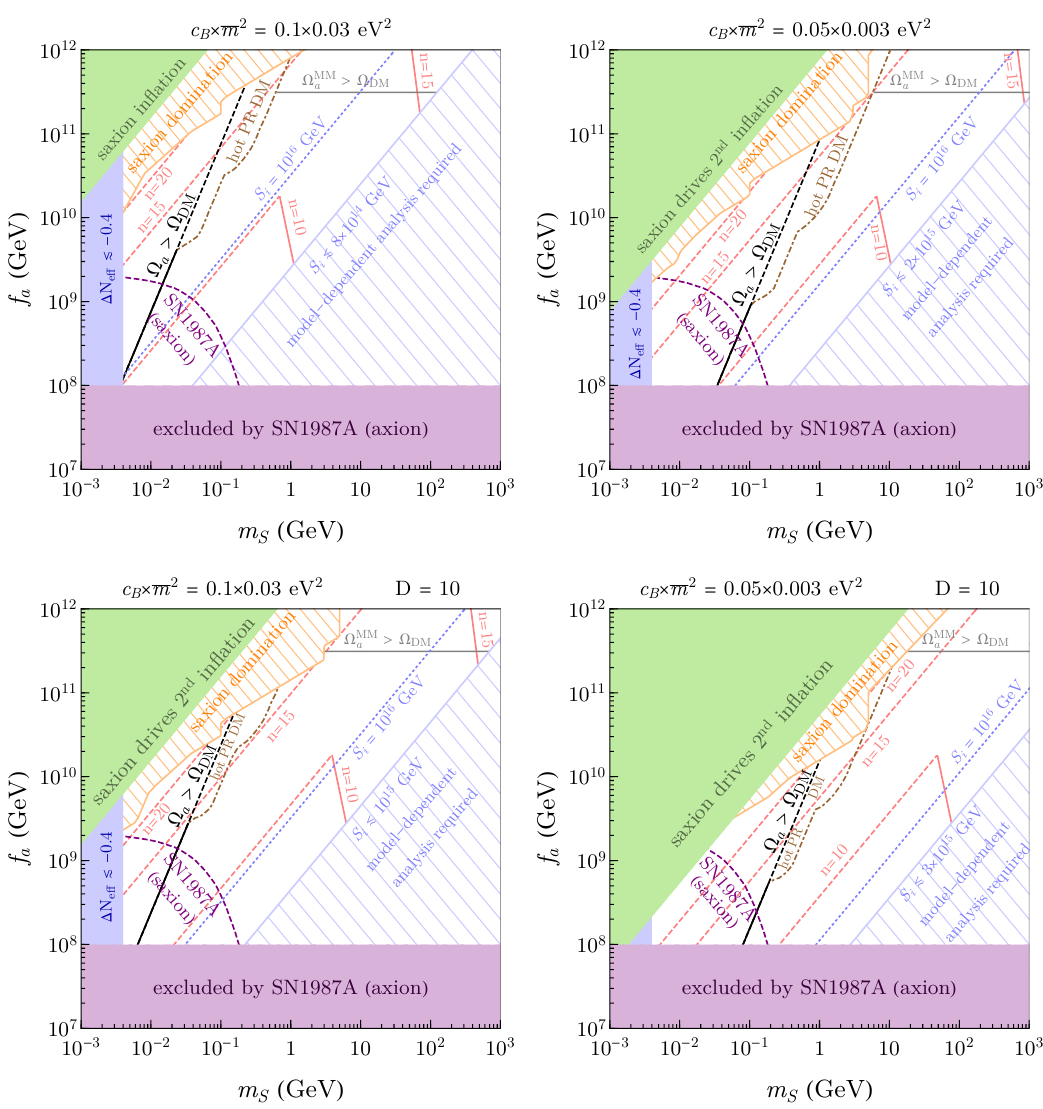
Figure 3 . Parameter space compatible with the observed baryon asymmetry for the quartic po- tential for N DW = 1 . The upper panels assume a radiation-dominated universe throughout the evolution, while the lower panels include a dilution factor of D = 10 that can arise from late-time entropy production. Left (right) panels are for larger (smaller) c B × ¯ m 2 as labeled. We fix (cid:15) = 0 . 125 , which affects the black and pink solid lines. lower right panel belongs to the second case in eq. (3.12), i.e. T while T < T for the other three osc ss